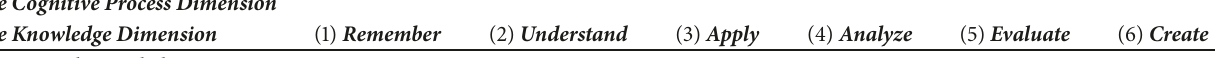
The Cognitive Process